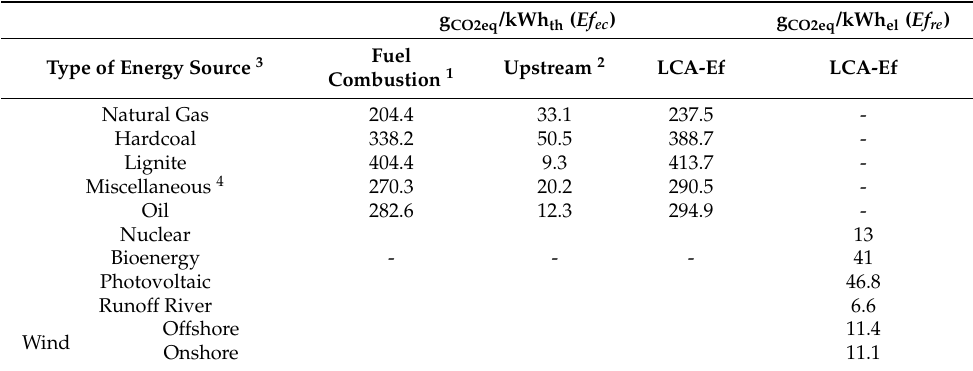
Table 1. Emission factors used for the different energy